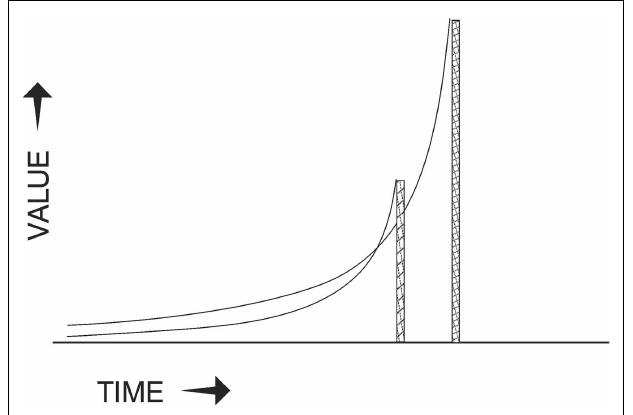
FIGURE 1 | Hyperbolic curves describing the values of a smaller, sooner (SS) reward and a larger, later (LL) reward as the delay before they will be available decreases . An early choice (near the left edge) would favor the LL reward, but a choice when the pair is close would favor the SS